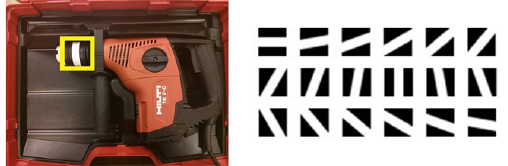
Figure 2. Target object (yellow box) and its